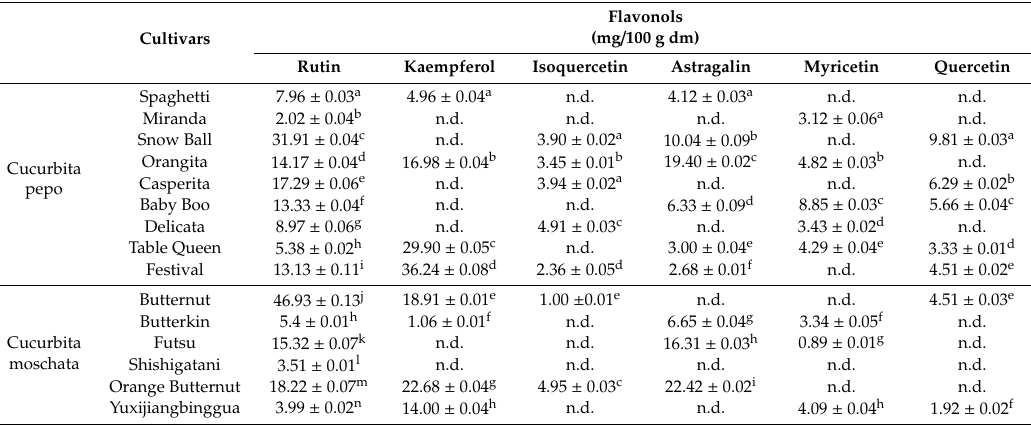
Table 3. The content of flavonols in pumpkin